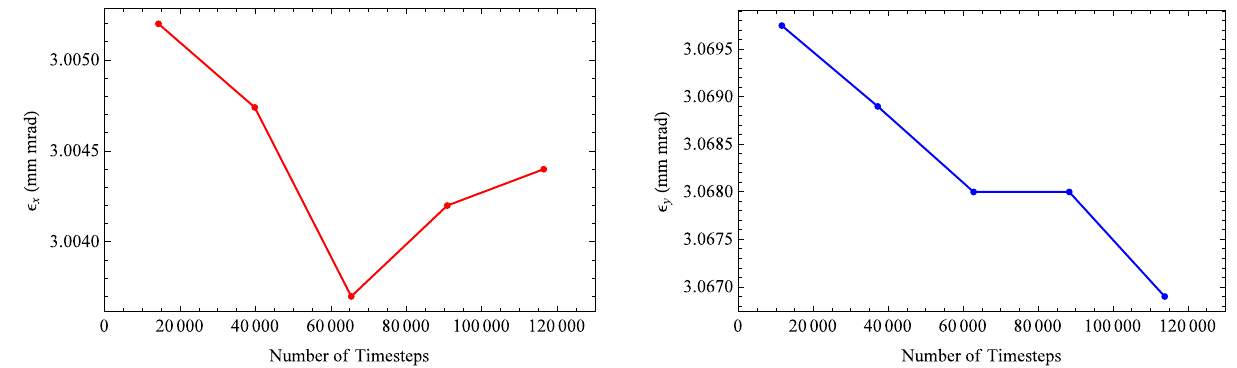
FIG. 17. Maxima of the horizontal (left) and vertical (right) emittances curves of the proton beam bunch of 1 cm radius cooled with an electron beam of the same radius, B